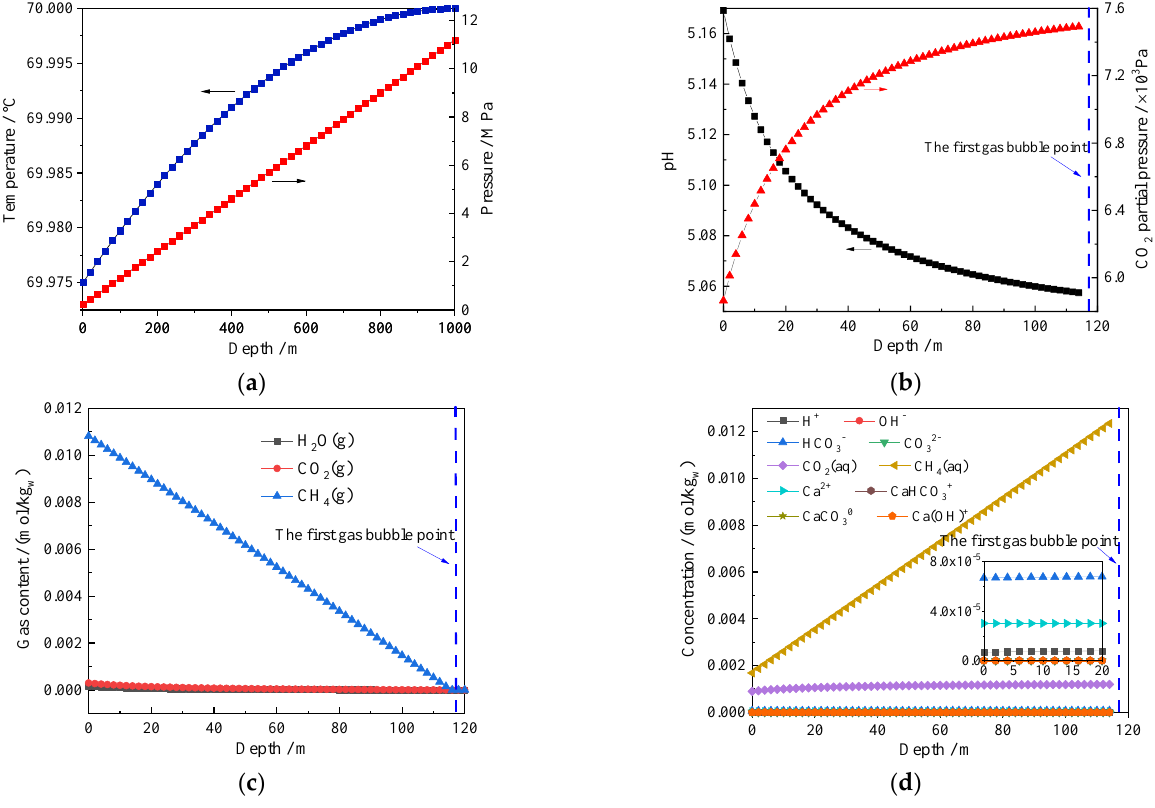
Figure 5. ( a ) Temperature and pressure distribution along the well; ( b ) CO 2 partial pressure and pH evolution after the first gas bubble point; ( c ) concentration evolution of gas components after the first gas bubble point; ( d ) concentration evolution of liquid components after the first gas bubble point.